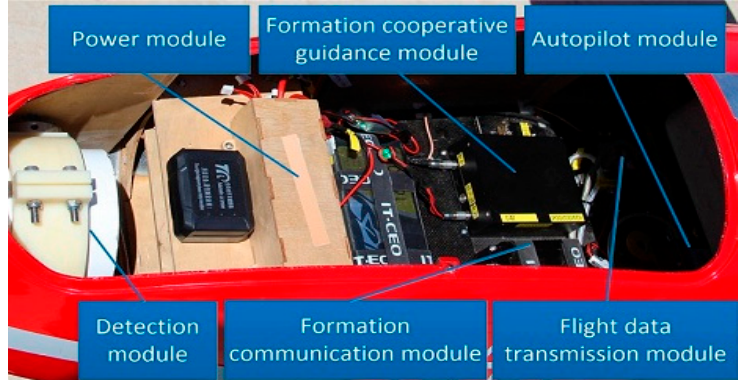
Figure 8. The loads in the cabin of the UAV.